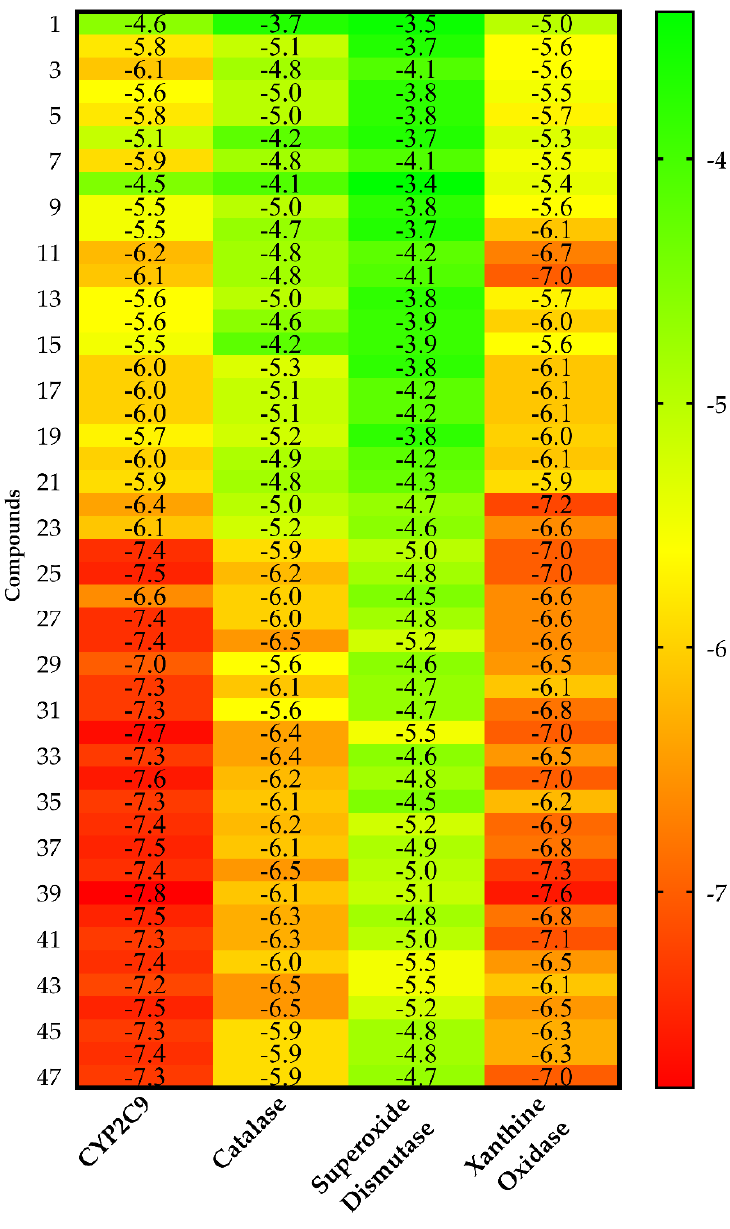
Figure 2. Heat map of the intermolecular docking energy values (kcal · mol − 1 ) of VPEO components on CYP2C9, catalase, superoxide dismutase, and xanthine oxidase proteins. Values are listed as a three-colored scheme from red (high energy) to green (low energy).